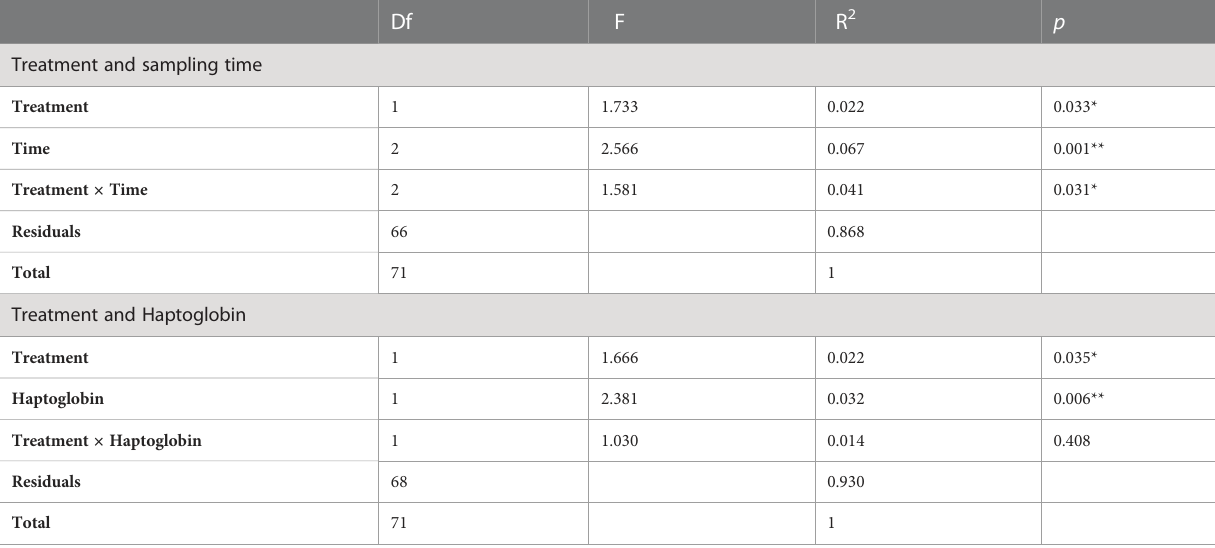
TABLE 1 The effect of treatment (control vs . LPS), sampling time (0h, 24h, 48h) and haptoglobin concentration on the gut bacterial community composition of fruit bats.